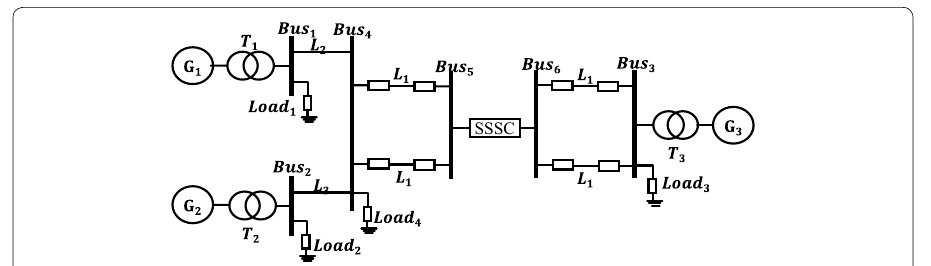
Fig. 1 Three-machine power system with